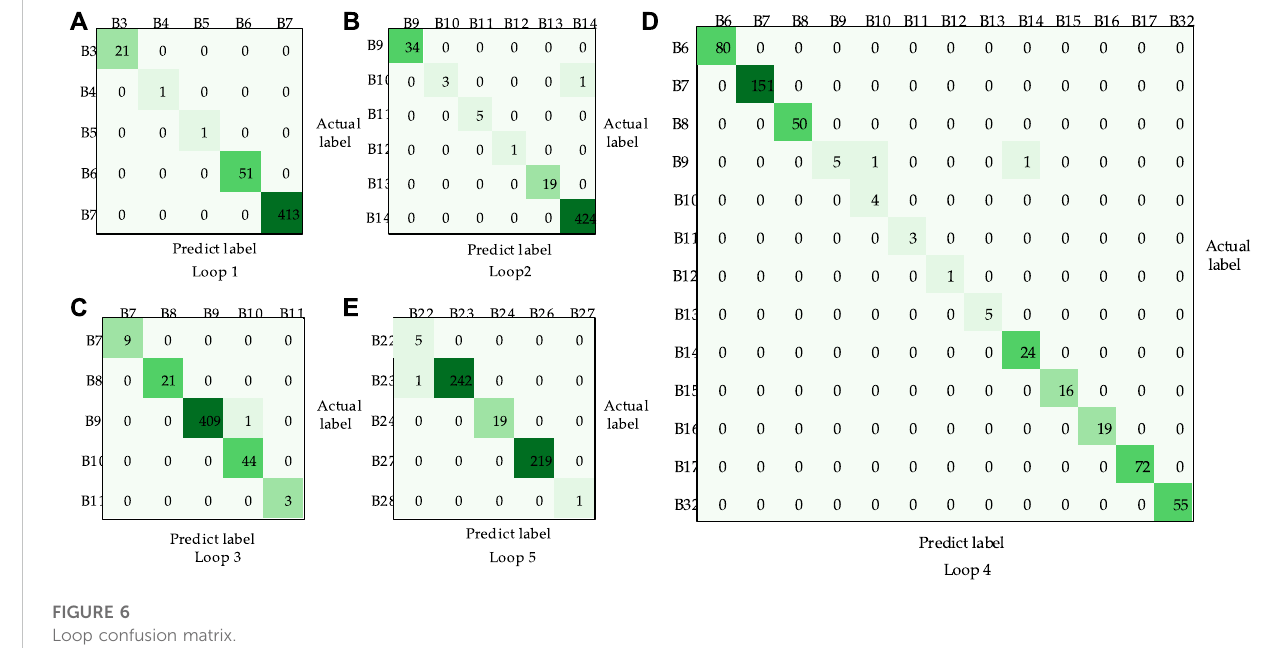
FIGURE 6 Loop confusion matrix.